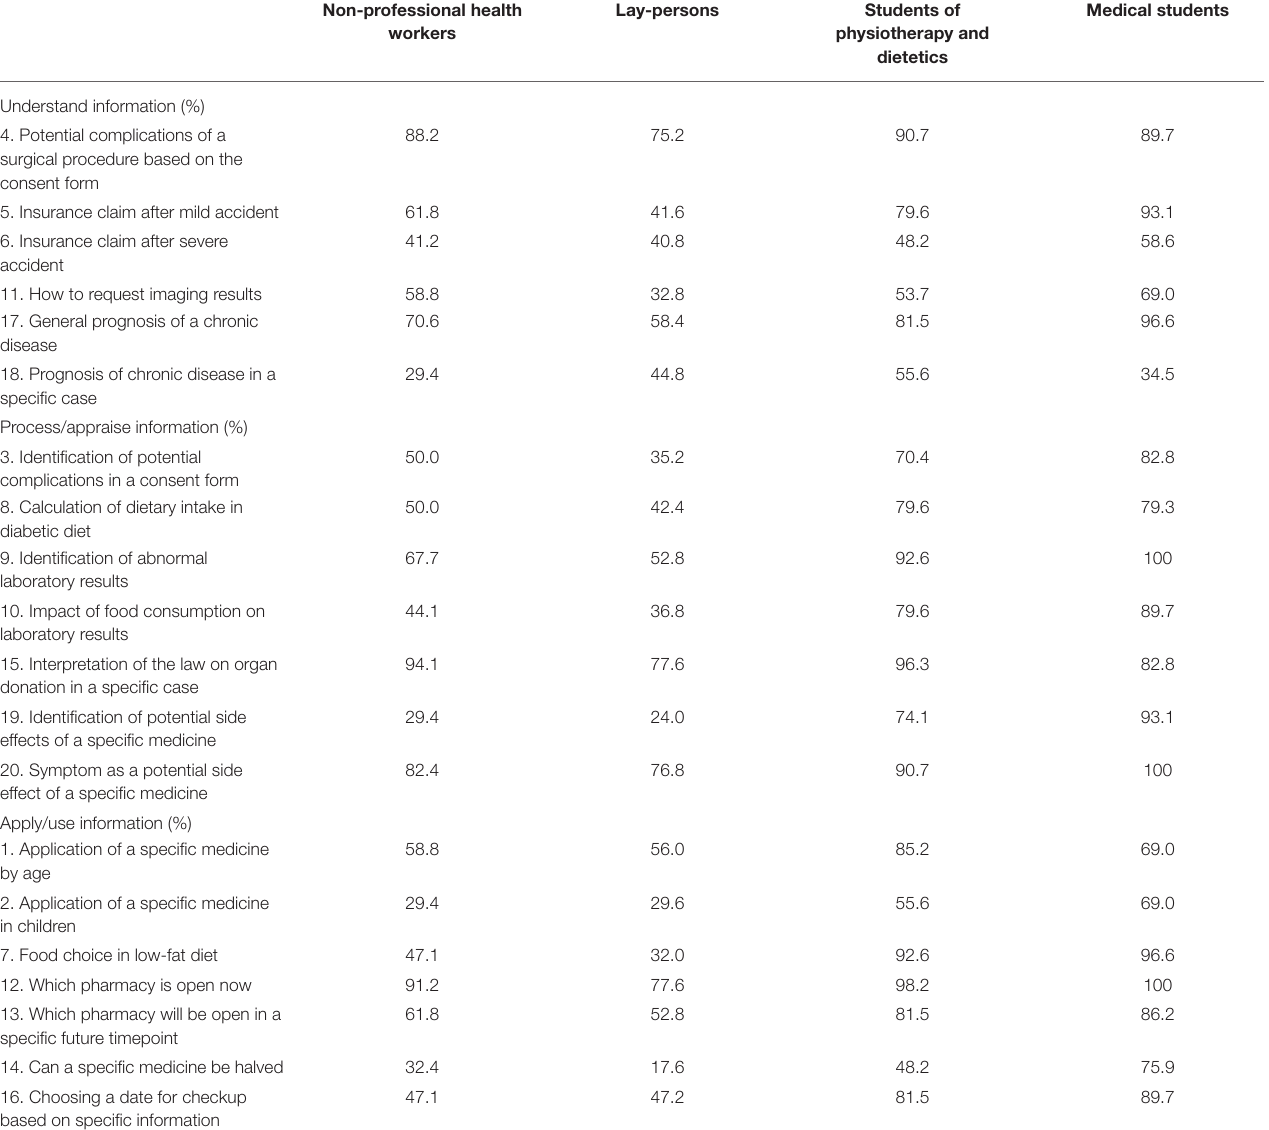
TABLE 3 | Uncorrected proportion of right responses by item and occupational/study groups.